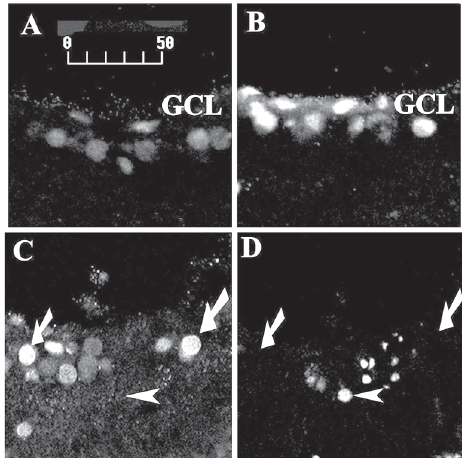
Figure 2. A,B , Immunostaining for Max in explants at 30 h in vitro , from retinae intravitreally injected either with PBS (A) or with recombinant adeno-associ- ated viral (rAAV)- max (B). Notice the increased immunoreactivity in the retina injected with rAAV- max , even after 30 h in vitro . C,D , Matching confocal photo- micrographs of the ganglion cell layer (GCL) of retinal explants af- ter 30 h in vitro stained either for Max (C) or TUNEL (D). Notice that condensed TUNEL-positive nuclei belong to cells devoid of Max (arrowheads), while Max overexpressing cells show a healthy morphology (arrows). Scale = 50